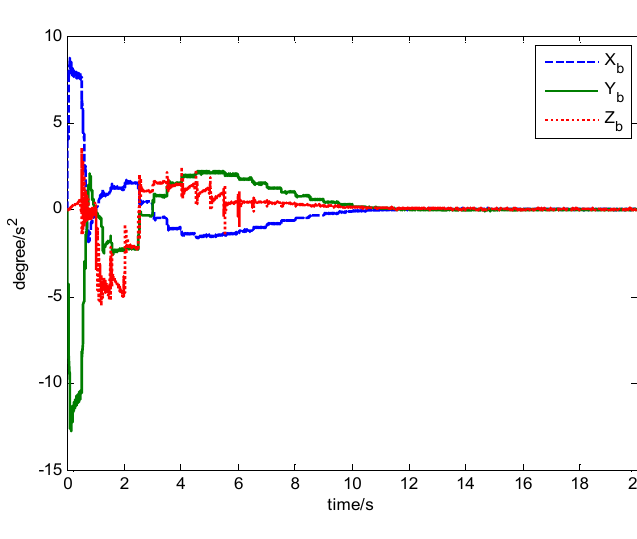
Figure 12. Satellite angle acceleration.